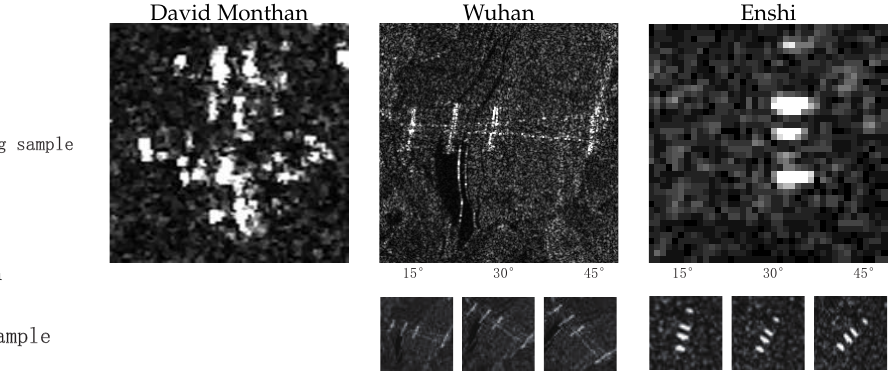
Figure 4. Illustration of the samples in the three experimental data sets.